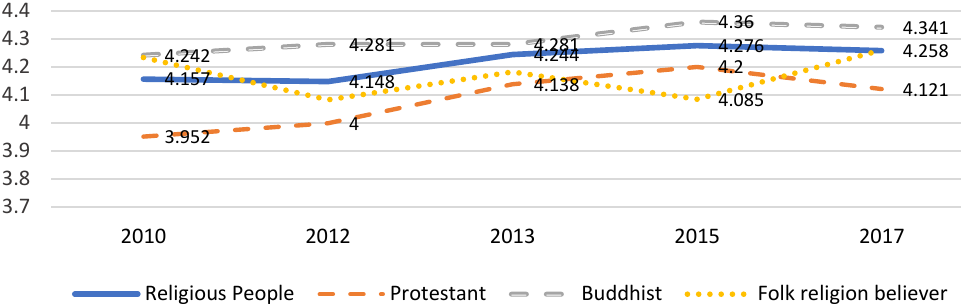
Figure 3. Changes in the subjective class identity of religious believers.